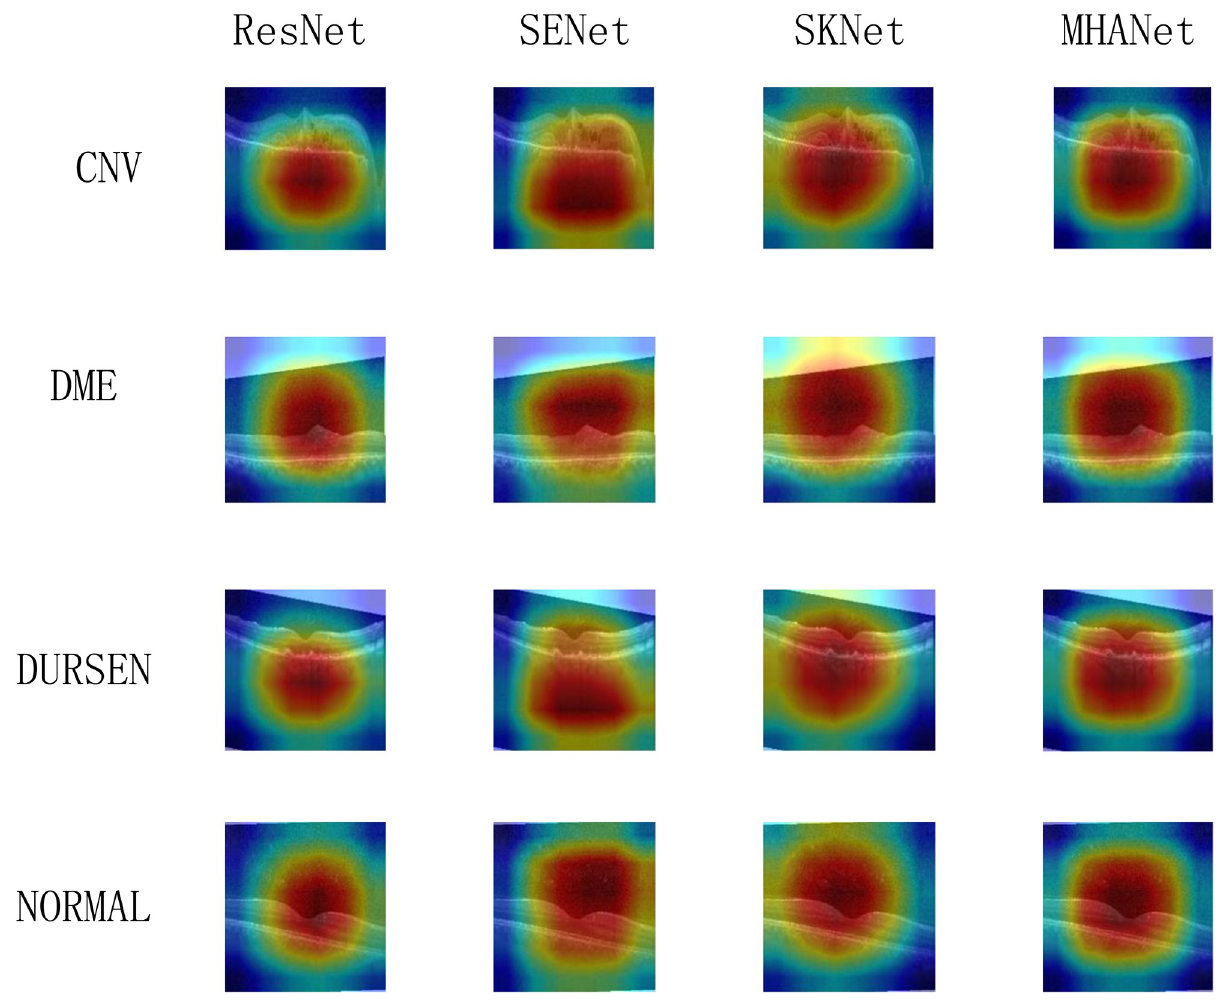
Fig 12. Heat map of